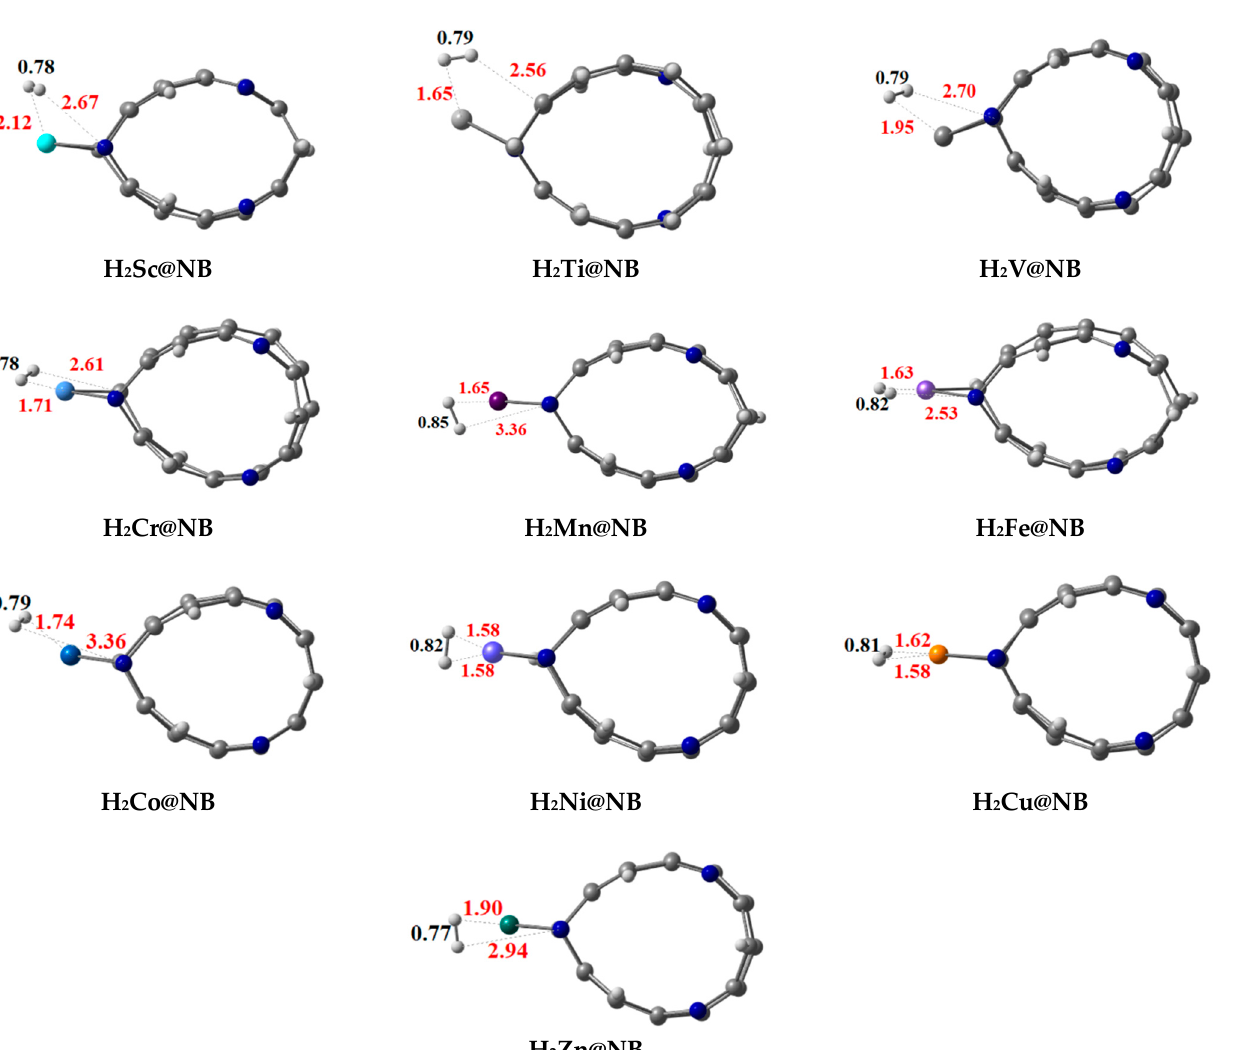
Figure 4. Optimized structures of stable hydrogen molecule-adsorbed TM@NB complexes (TM = Sc-